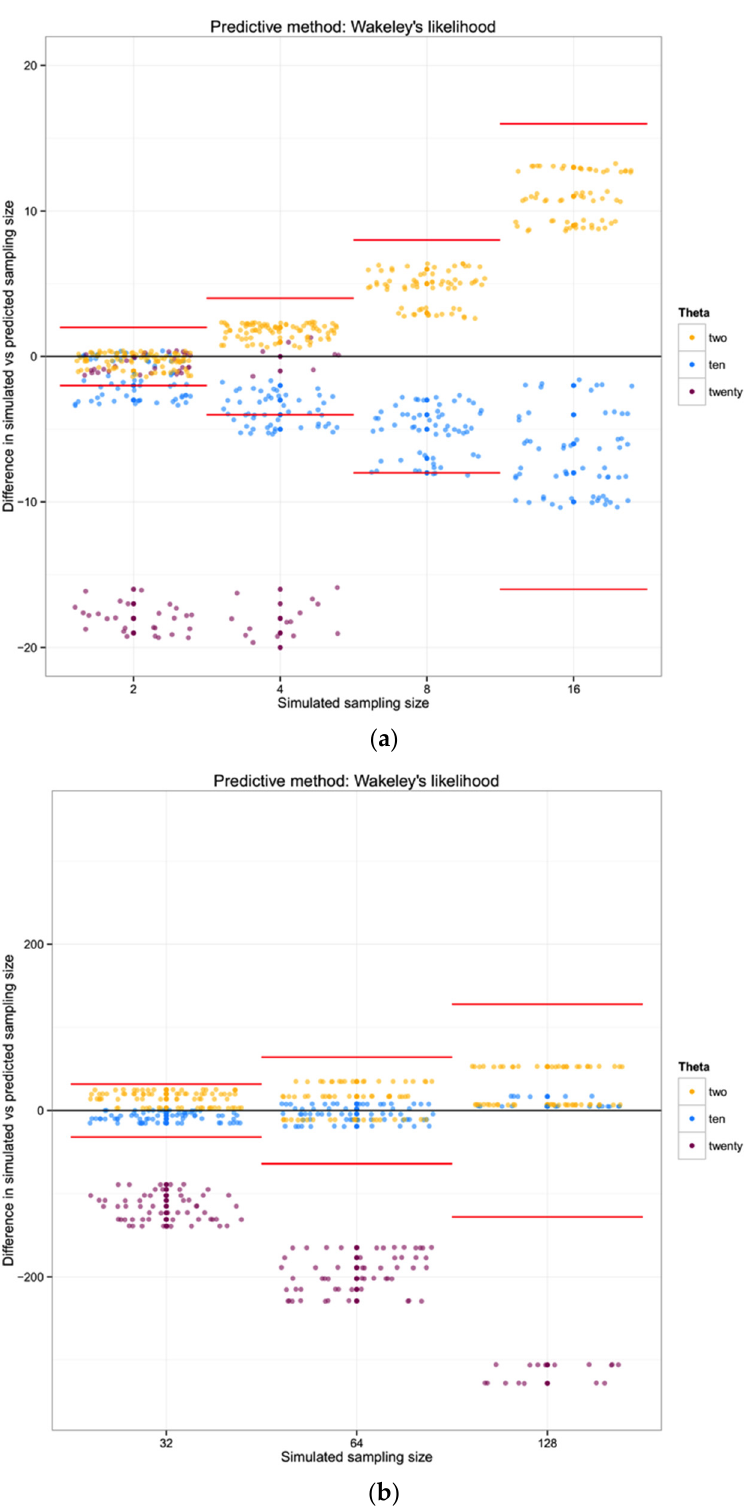
Figure 5. Difference between the simulated sampling size and the sampling size for the sample predicted using Wakeley’s segregating sites theory. ( a ) sampling sizes of 2, 4, 8 and 16; ( b ) sampling sizes of 32, 64 and 128. The zero line shows the ideal situation in which the estimation equals the simulated sampling size. The red lines show the limit where the difference between simulated and predicted equals the sampling size; that is, beyond the red lines the error is too large to make a sensible prediction. Please note that the data are jittered to enhance visualization, and that the y-axis differs between ( a ) and ( b ).